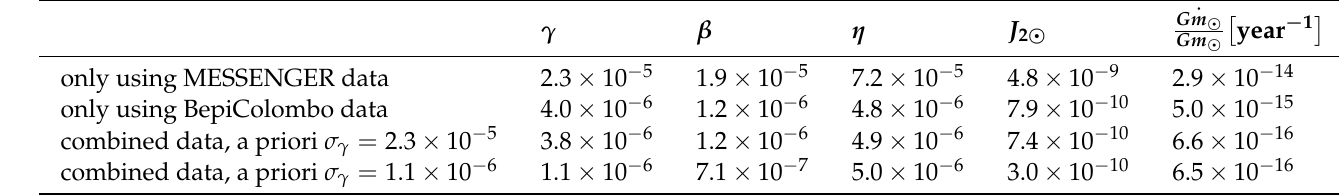
Table 3. Formal uncertainties (1 σ ) of estimated gravity parameters and solar oblateness when using the method described in Section 2, except that only a static J 2 (cid:12) is included in the virtual reality and the estimation and no other spherical harmonics effects. Simulations are performed for various types of inputs, as indicated in the first